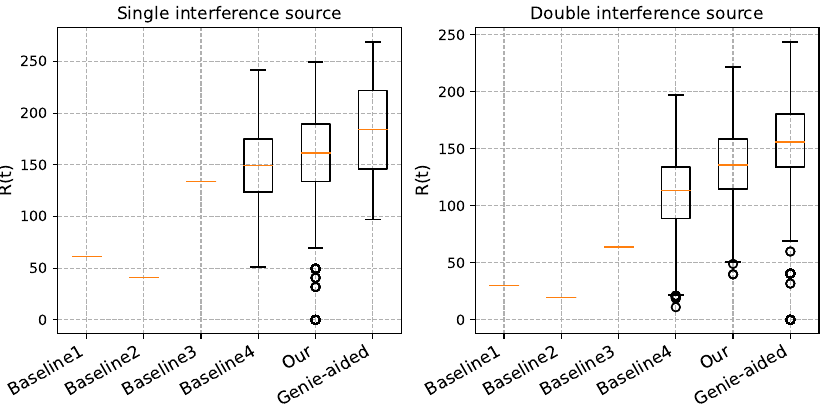
Figure 10. The box plot of total throughput for 100 time slots in each training episode under the prototyping